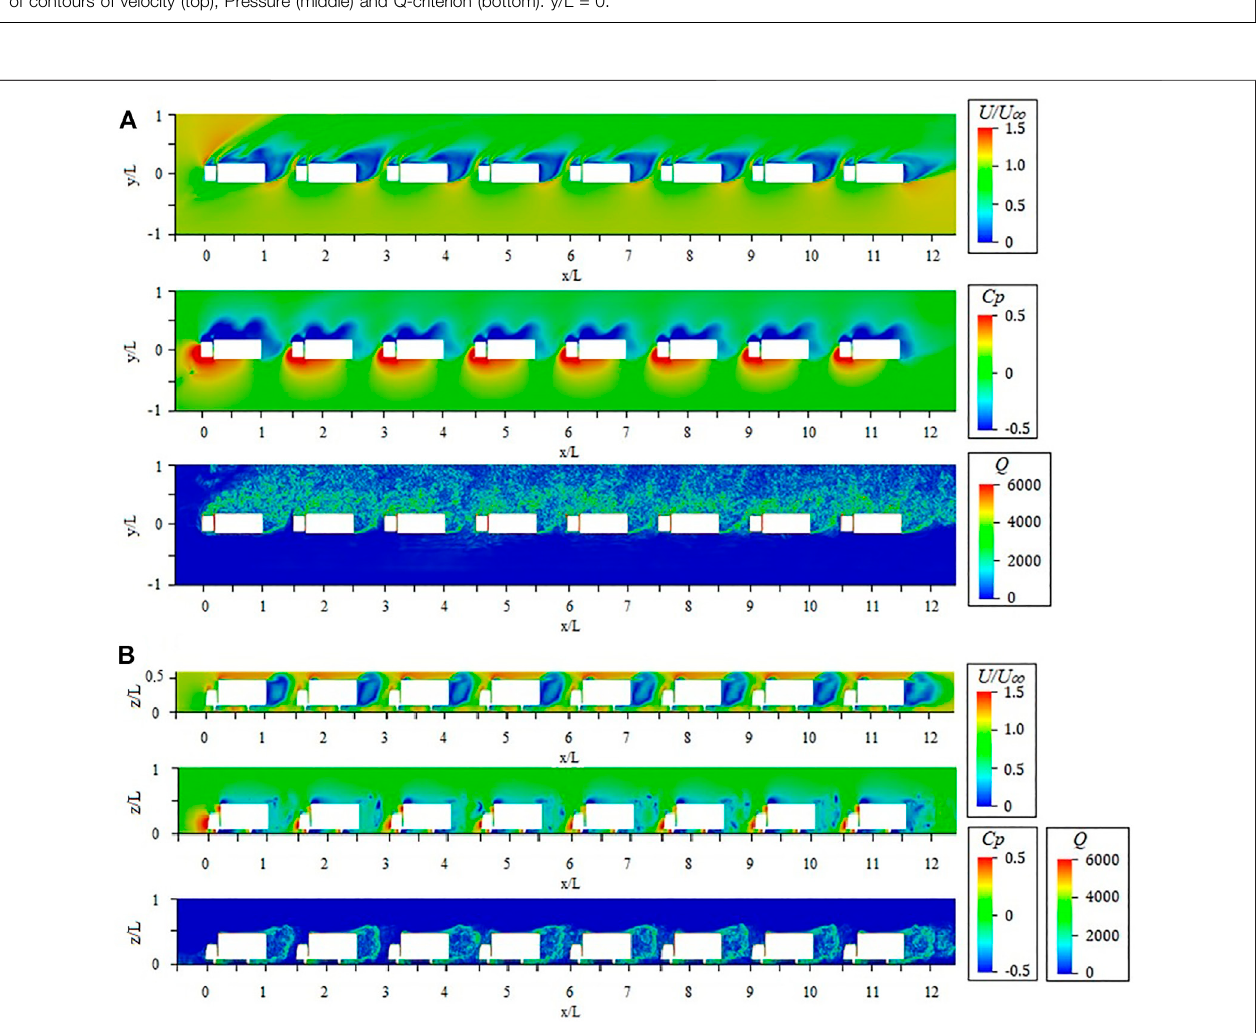
FIGURE 7 | Comparisons of moment coef fi cients of lorries in a platoon with the presence of crosswind.